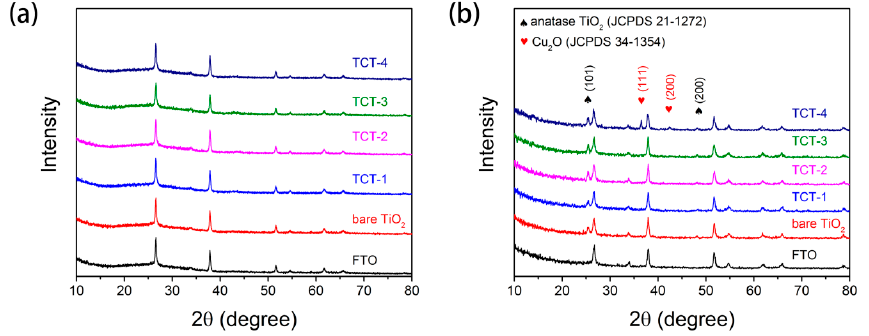
Figure 2. XRD pattern of FTO, bare TiO 2 and different TCT samples before ( a ) and after ( b ) annealing. Materials 2020 , 13 , x FOR PEER REVIEW